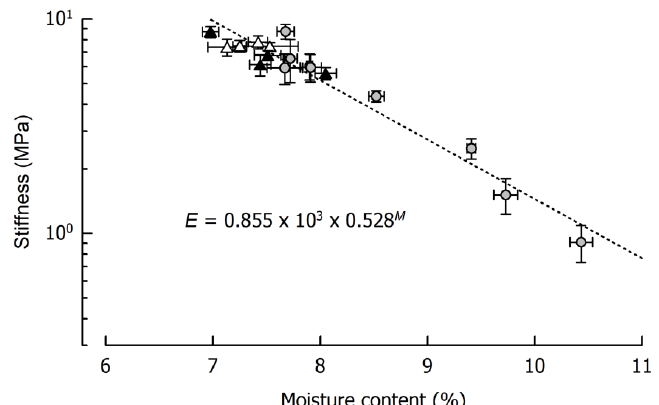
Figure 2. Relationship between caramel stiffness E and moisture content M . Data are arithmetic means ± standard deviation for stiffness ( n = 7) and for moisture ( n = 3). Symbols: Formulations Ref (grey circles), SFC1 (black triangles), SFC2 (open triangles). Equation refers to the fit indicated by the dotted line.